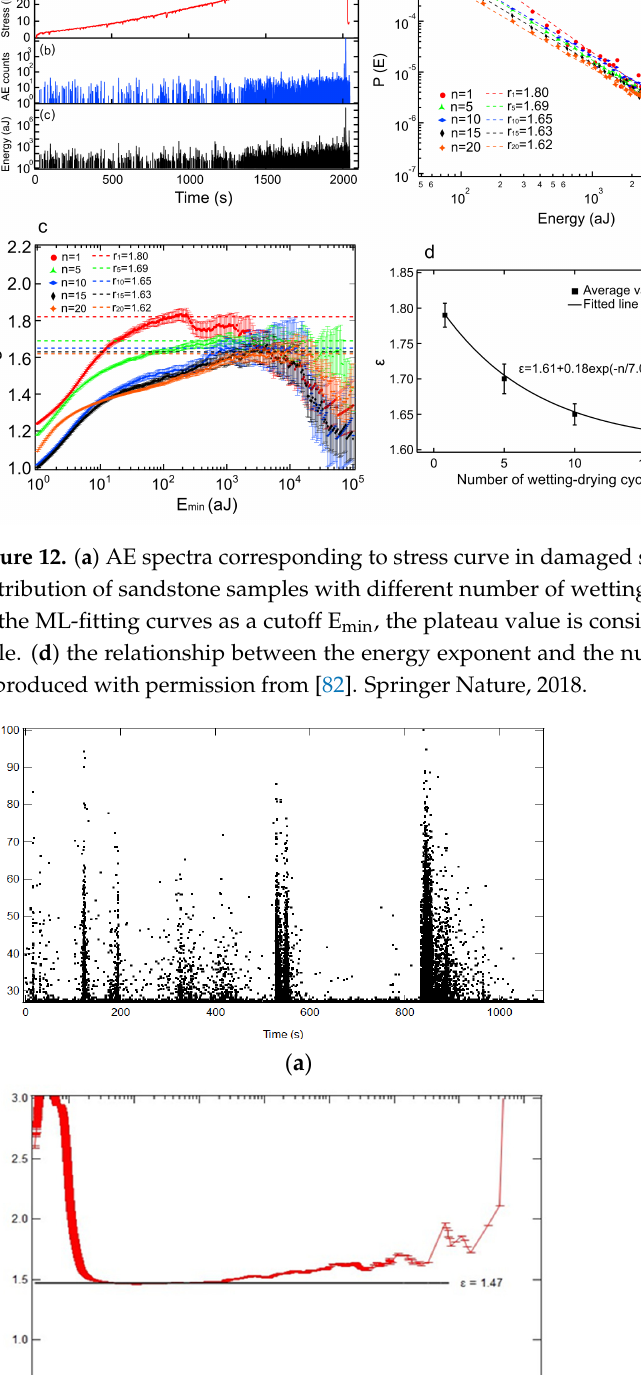
Figure 12. ( a ) AE spectra corresponding to stress curve in damaged sandstone. ( b ) The AE energies distribution of sandstone samples with different number of wetting–drying cycle in log–log scale. ( c ) the ML-fitting curves as a cutoff E min , the plateau value is consistent with the slope in log–log scale. ( d ) the relationship between the energy exponent and the number of cyclic wetting events. Reproduced with permission from [82]. Springer Nature, 2018.